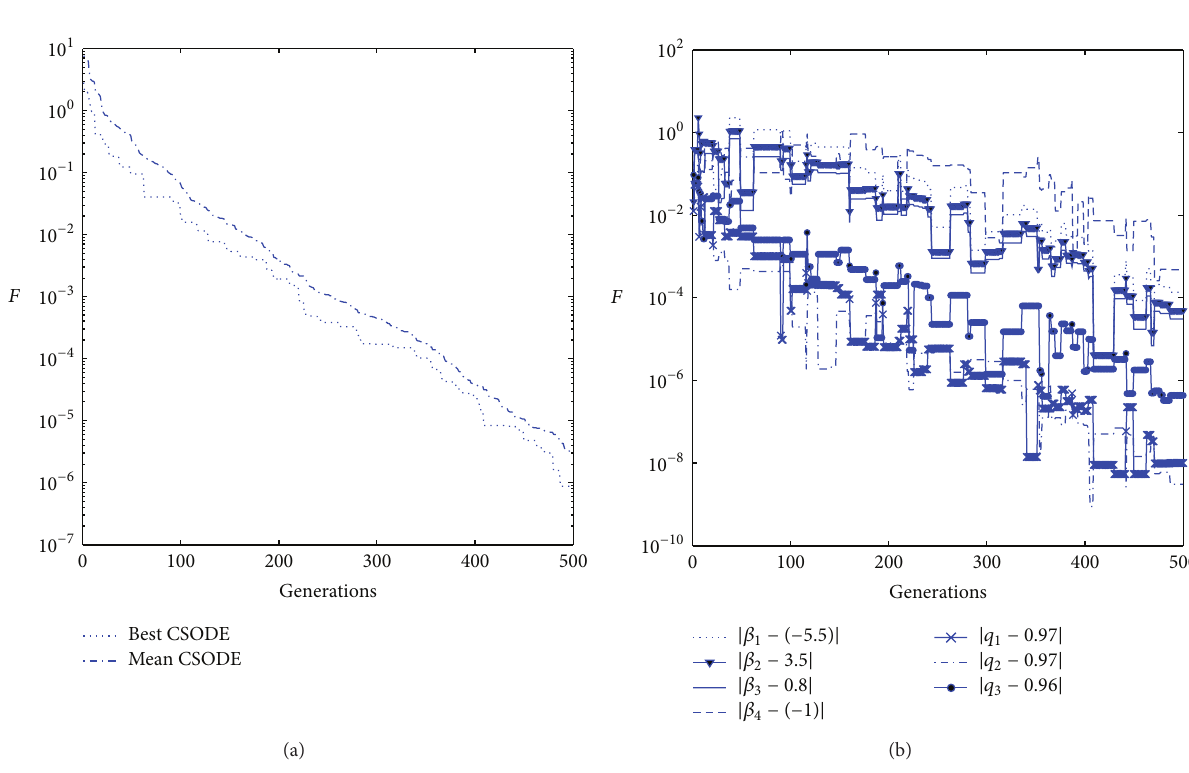
Figure 4: Evolution process for fractional-order Arneodo